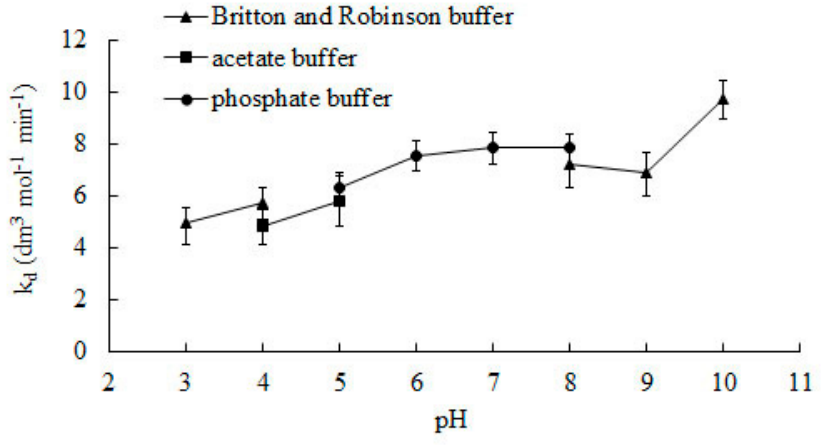
Figure 3. The effect of the pH of the reaction medium on the rate constant of deactivation during the enzymatic process. Error bars represent standard deviation mean of three replicates whilst means with the same letters in the same observation are not significantly different at 0.05 level of the LSD test.